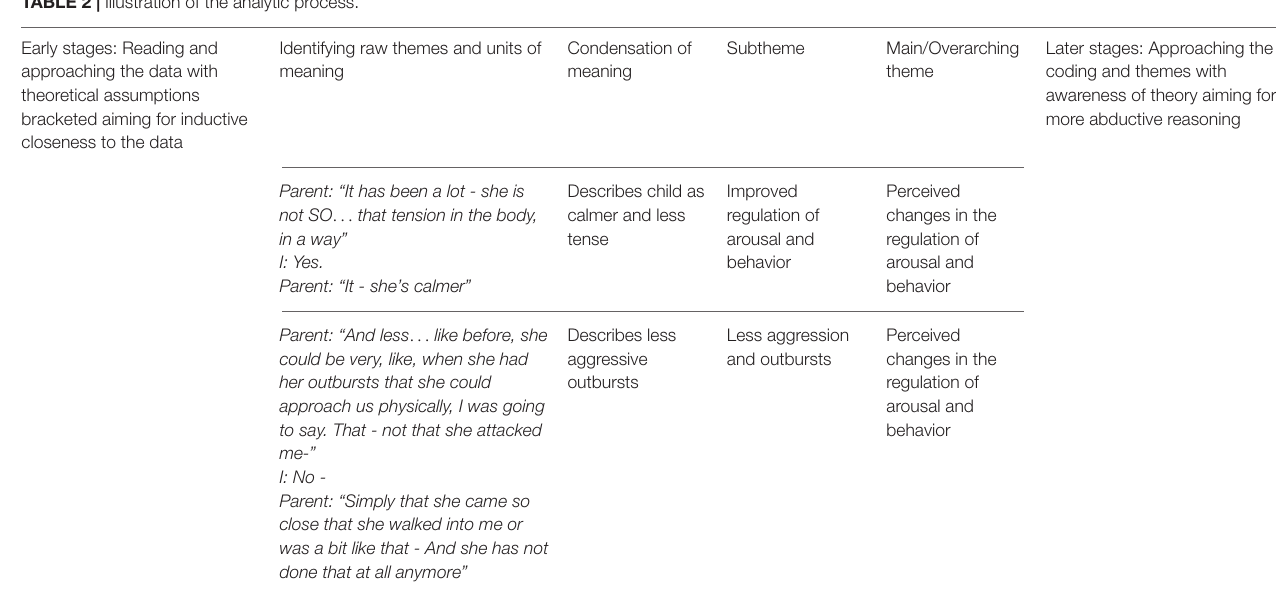
Identifying raw themes and units of meaning